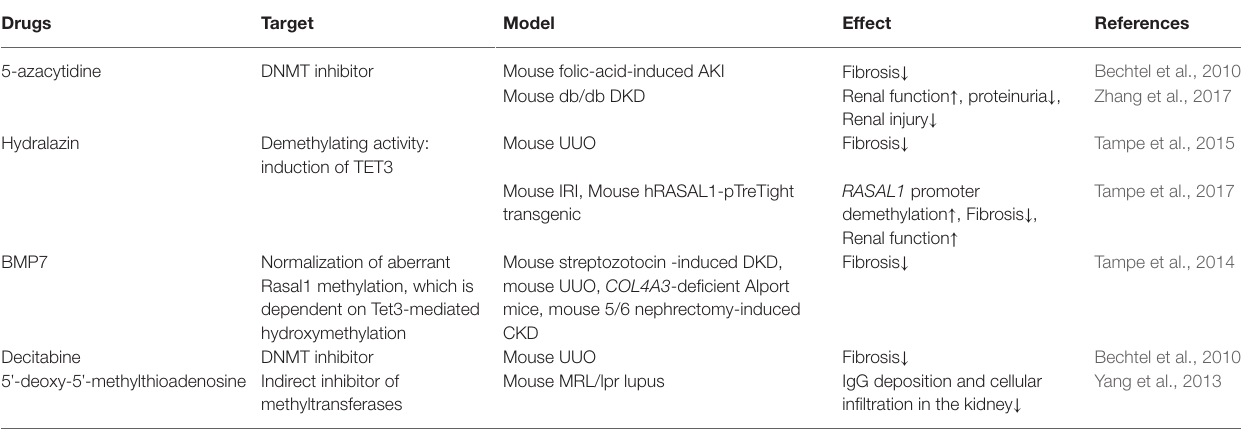
TABLE 2 | Summary of existing potential treatment of CKD targeting on DNA methylation.